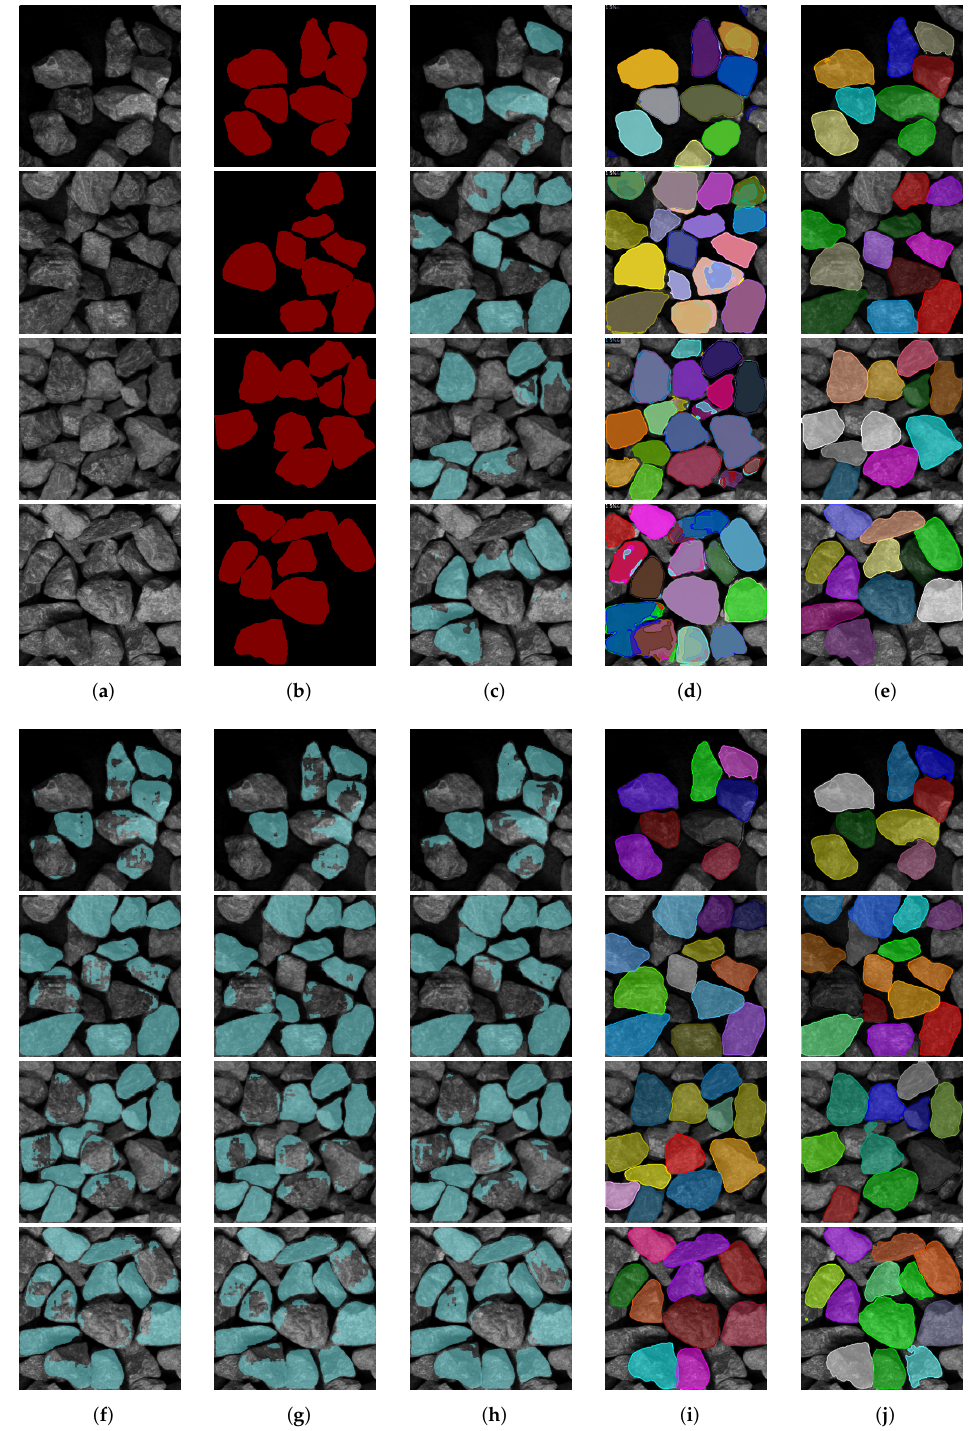
Figure 8. The visual results of ore images processed by different methods. ( a ) Original picture; ( b ) ground truth; ( c ) YOLACT; ( d ) SOLOv2; ( e ) CondInst; ( f ) Mask R-CNN; ( g ) MS R-CNN; ( h ) CARAFE; ( i ) LosNet(R-50); ( j )